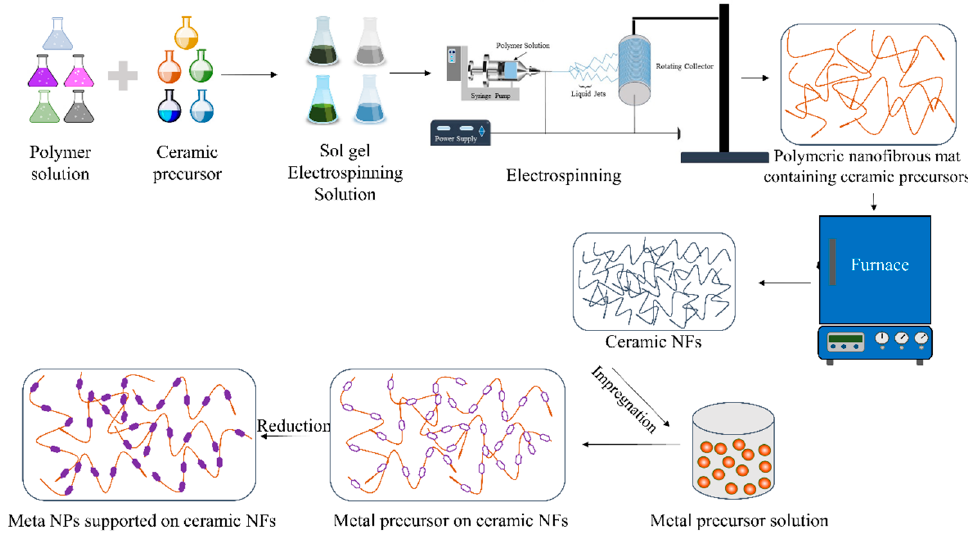
Figure 3. Preparation steps of supported ceramic nanofibrous catalysts using